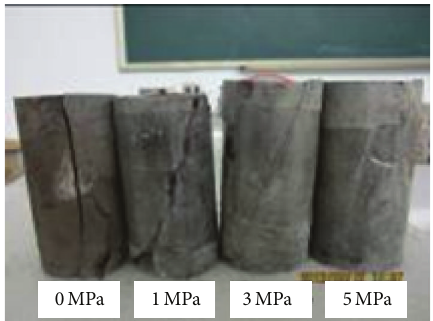
Figure 9: Changes of failure modes of coal samples under different confining